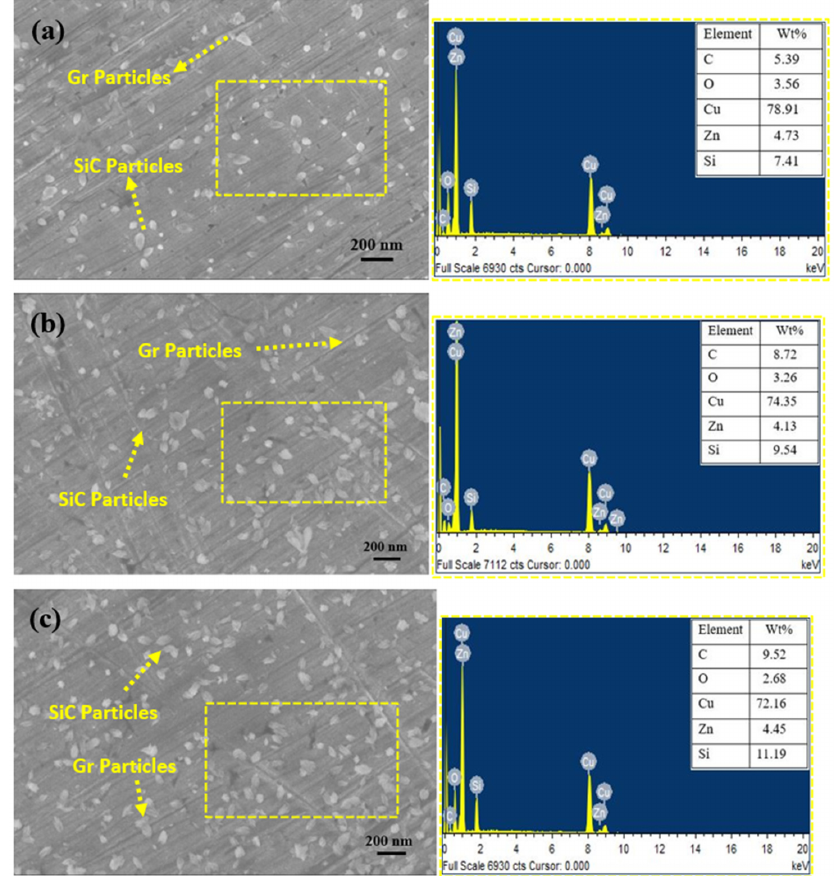
Figure 5. FESEM micrograph and EDX analysis of Cu-SiC-Gr hybrid composites with SiC variation of ( a ) 3, ( b ) 6, and ( c ) 9 wt.%.